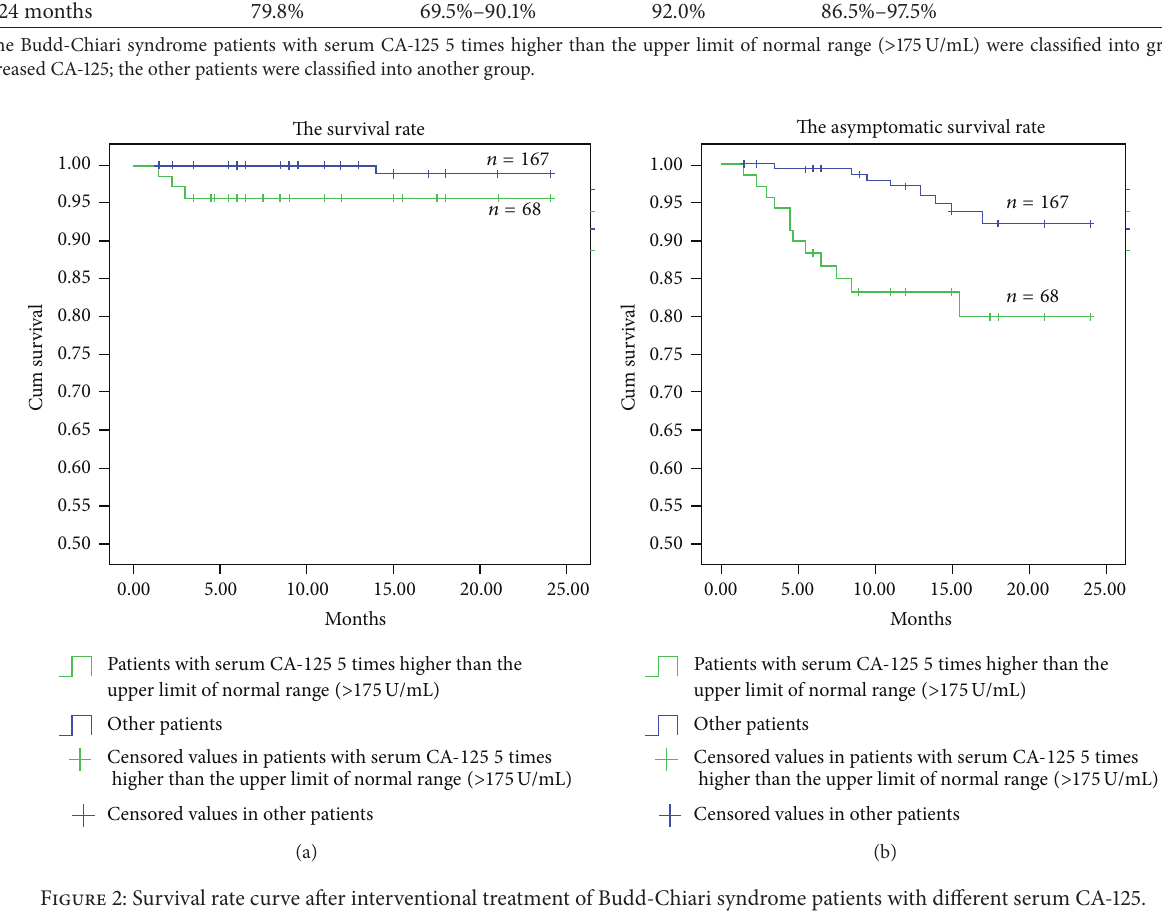
Figure 2: Survival rate curve after interventional treatment of Budd-Chiari syndrome patients with different serum